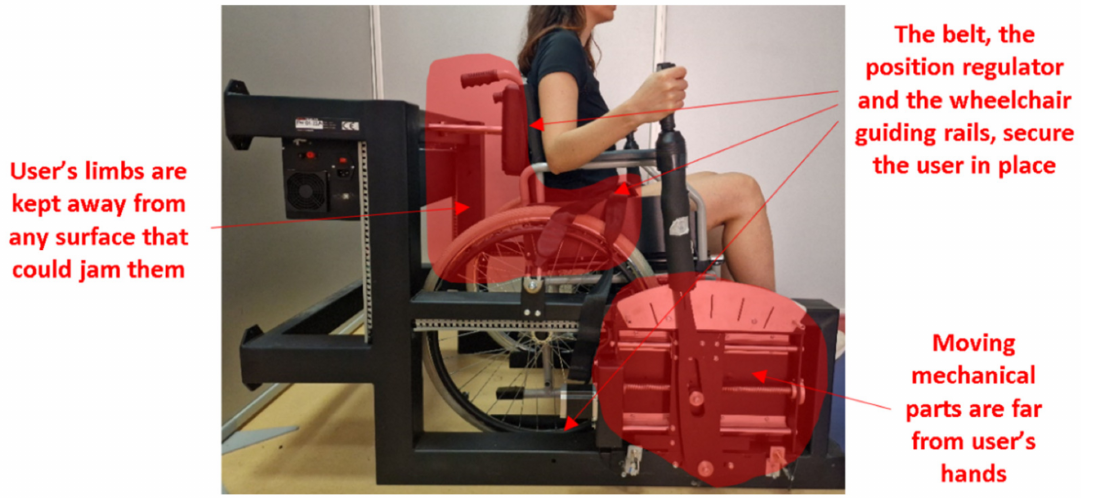
Figure 4. An overview of safety parameters taken into account during the design of the device.